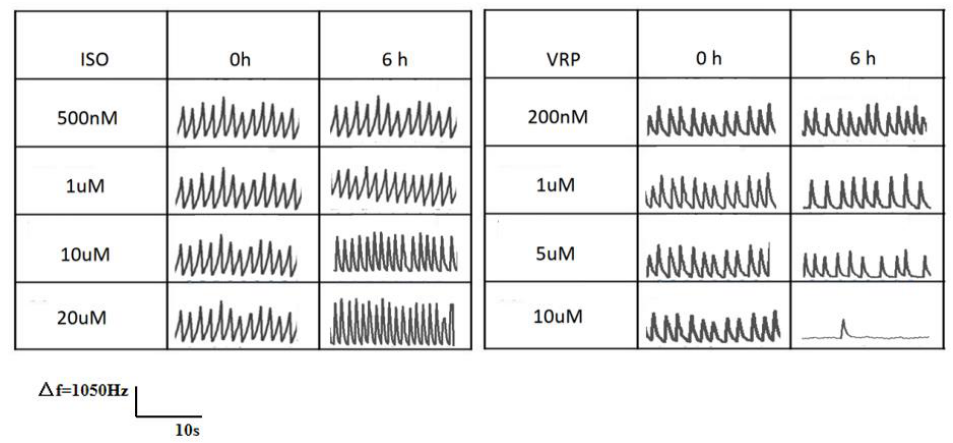
Figure 7. Beat signal changes in the cardiomyocyte QCM sensors after treatment with different concentrations of isoproterenol (ISO) and verapamil (VRP), with a time lapse of 10 s for the signal fragments and a maximum Δ f of 1050 Hz.